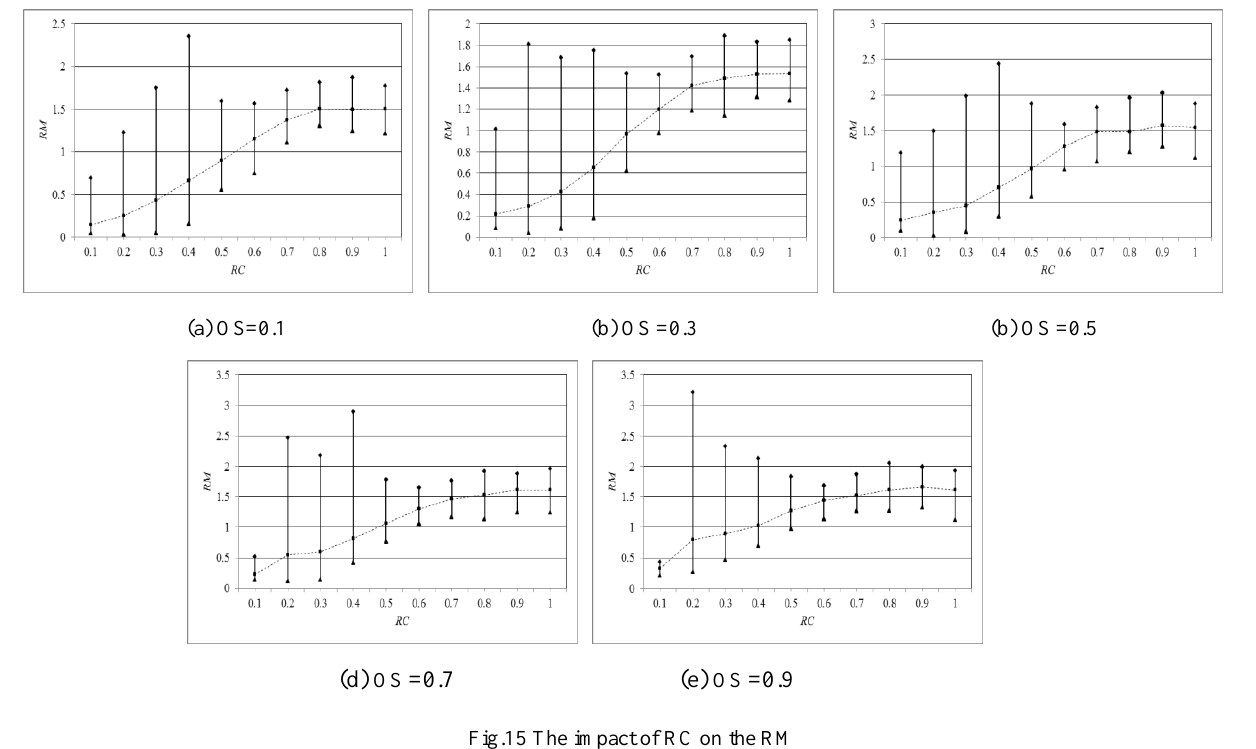
Fig.15 The impact of RC on the